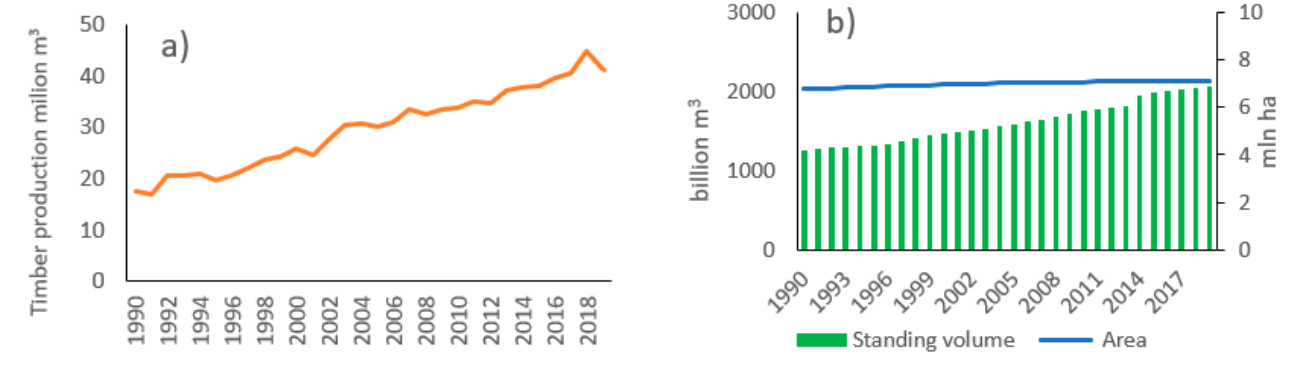
Figure 1. Output ( a ) and different inputs of timber production: ( b ) standing volume (left axis) and forested area (right axis); ( c ) labor costs; ( d ) costs of logging, silviculture, forest protection, and other costs. Inputs per 1 m 3 of timber produced in the years 1990–2019 are given in Table 2. In general, unit costs of logging and other costs increased approximately twofold, while there was a decrease in unit inputs of forest land (twofold), standing volume (0.4-fold), and labor (ninefold). Unit silviculture and forest protection costs were highly variable in the first decade of study, after which they stabilized at their initial levels. Table 2. Inputs per 1 m 3 of timber produced by the Polish State Forests in 1990–2019. Inputs